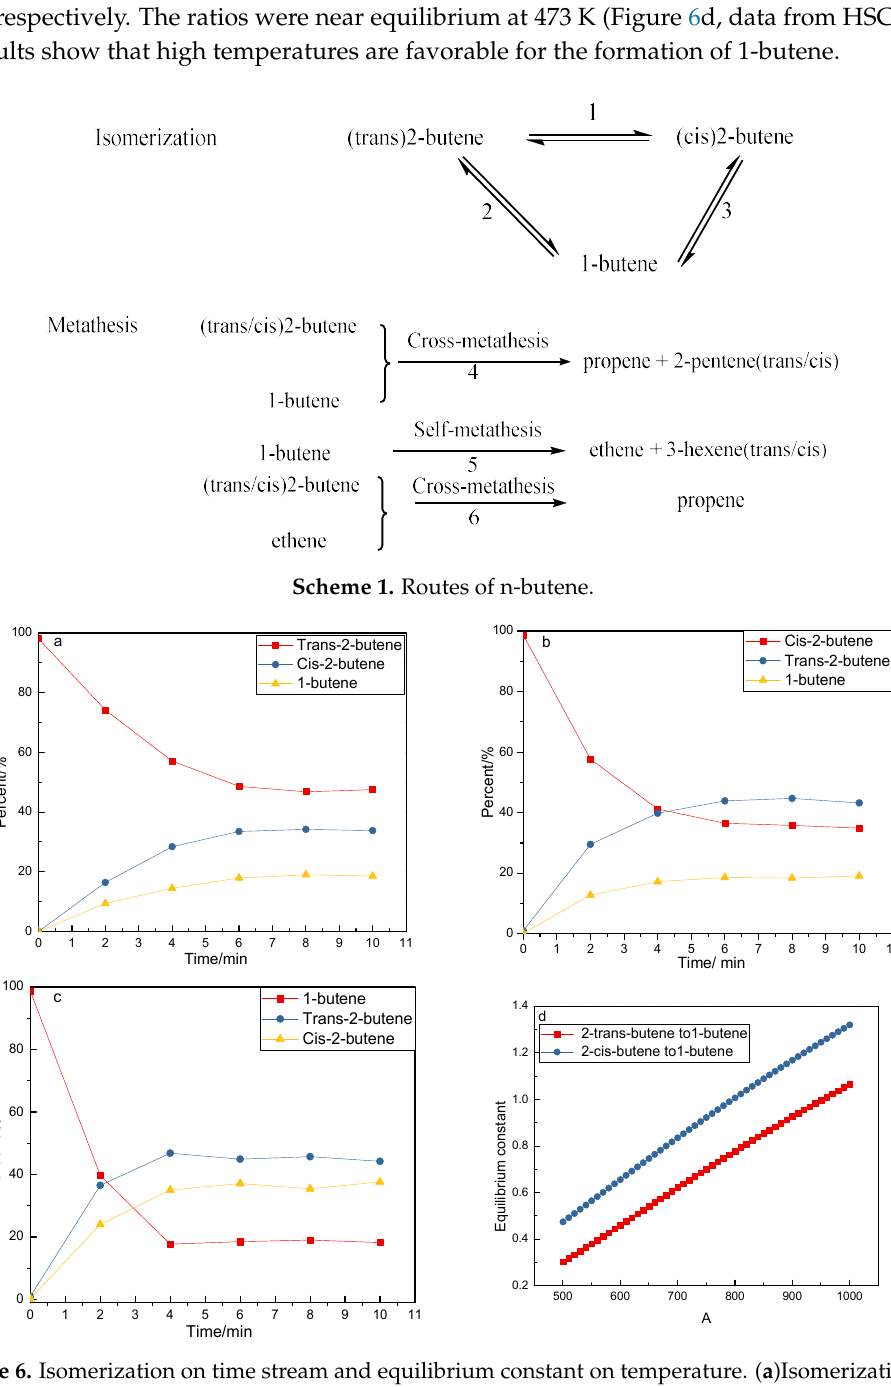
Figure 6. Isomerization on time stream and equilibrium constant on temperature. ( a )Isomerization of Trans-butene ( b ) Isomerization of Cis-butene ( c ) Isomerization of 1-butene ( d ) Equilibrium constants of Trans-2-butene to 1-butene and Cis-2-butene to 1-butene. Metathesis of butene is complex; the detailed reactions are shown in Scheme 1. Thermodynamic 2-butene and 1-butene (route 4), all reactions are exothermal except the reaction of T to C (trans-2-